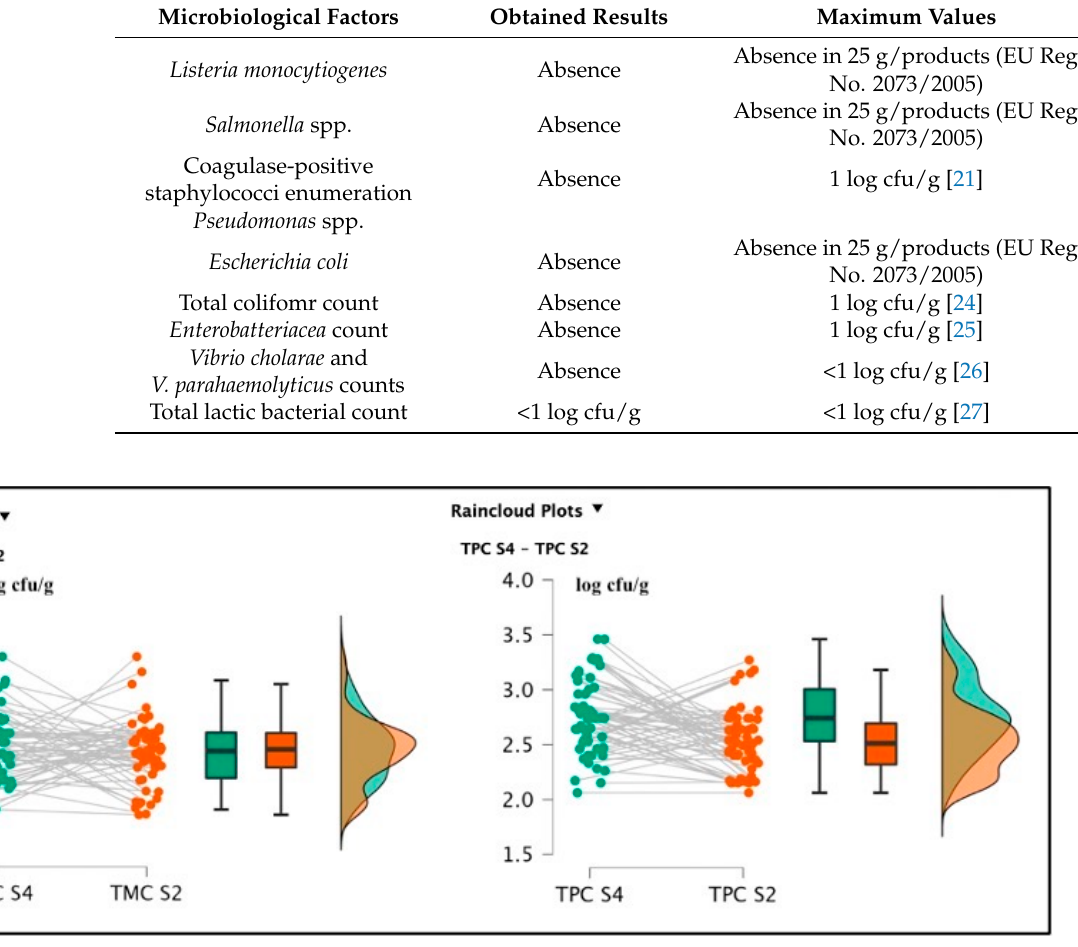
Figure 2. Raincloud plots representing the TMC and TPC of differently salted screened samples. For each graphic, the vertical axes report the calculated bacterial loads, and the horizontal axes indicate the screened TMC (on the left) or TPC (on the right) from the analyzed food matrices (S4–S2). Coagulase-negative staphylococci amounts were 2.3 ± 0.15 log cfu/g in S4 products [25/60 (41.67%)] and 2.7 ± 0.21 log cfu/g in S2 products [28/60 (46.67%)]. Pseudomonas spp. count value was 1 log cfu/g in 5/60 S4 samples (8.33%), but it was not detected in S2